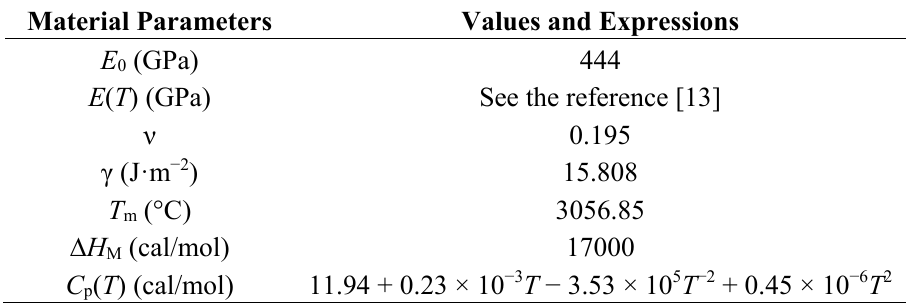
Table 1. Material properties of TiC